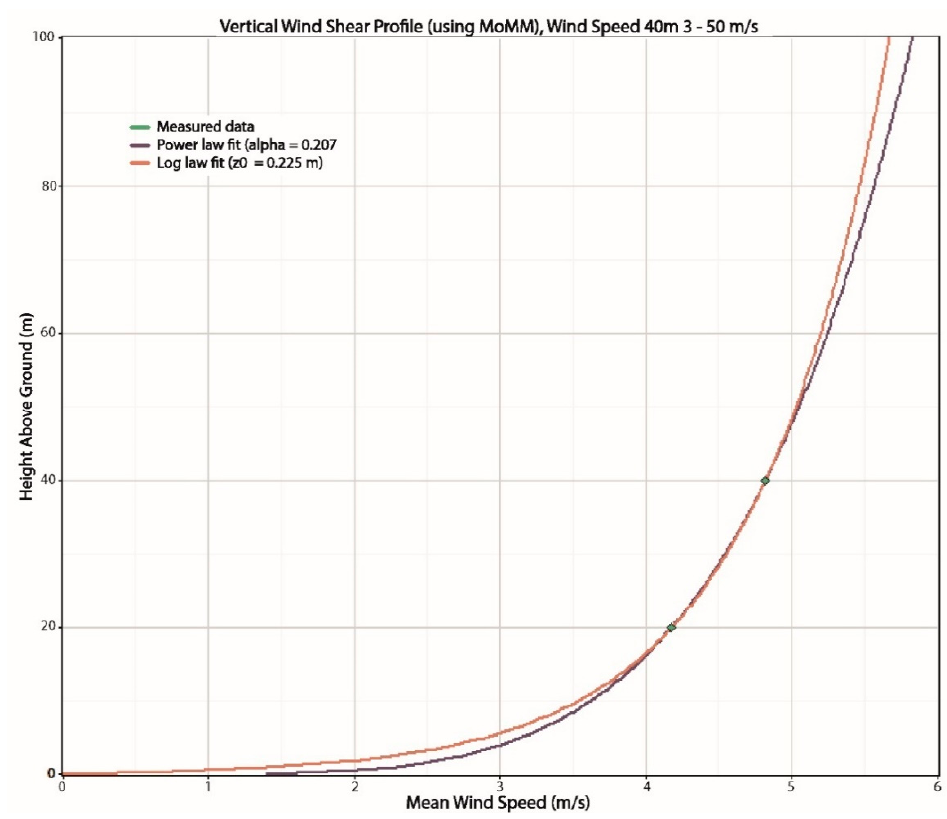
Figure 10. Wind variation as a function of height above ground. Source: generated by the software.